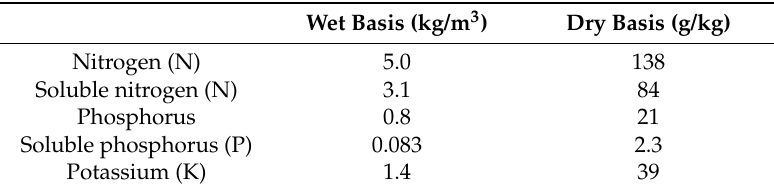
Table 3. Essential nutrient content of the solid phase of the anaerobic digestate.